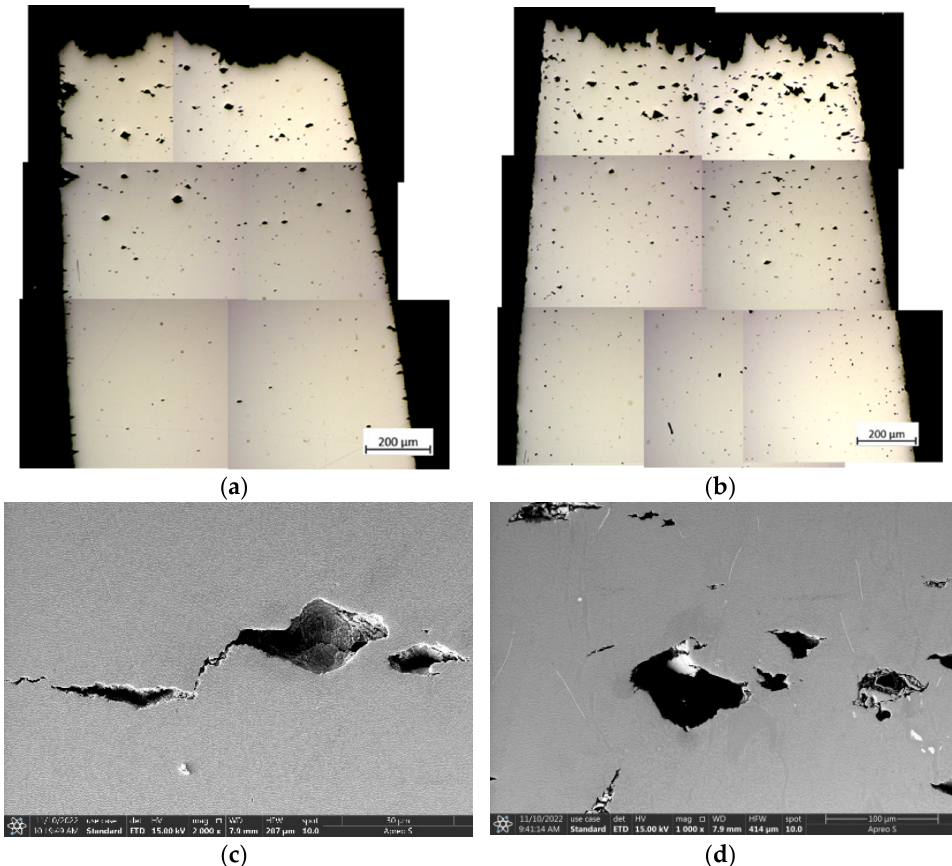
Figure 5. OM images of the longitudinal sections in the experimental superalloy after creep fracture at 1000 °C/300 MPa after overheating at 1100 °C/120 min ( a ) and 1300 °C/120 min ( b ); SEM images of the cracks in the longitudinal sections of the experimental superalloy after creep fracture at 1000 °C/300 MPa after overheated at 1100 °C/120 min ( c ) and 1300 °C/120 min ( d ).